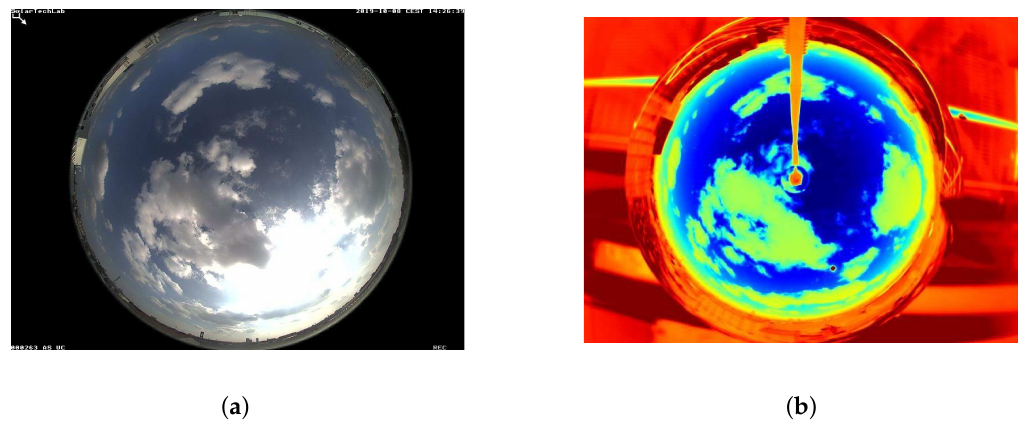
Figure 4. Comparison between sky images: visible ( a ) and infrared ( b )